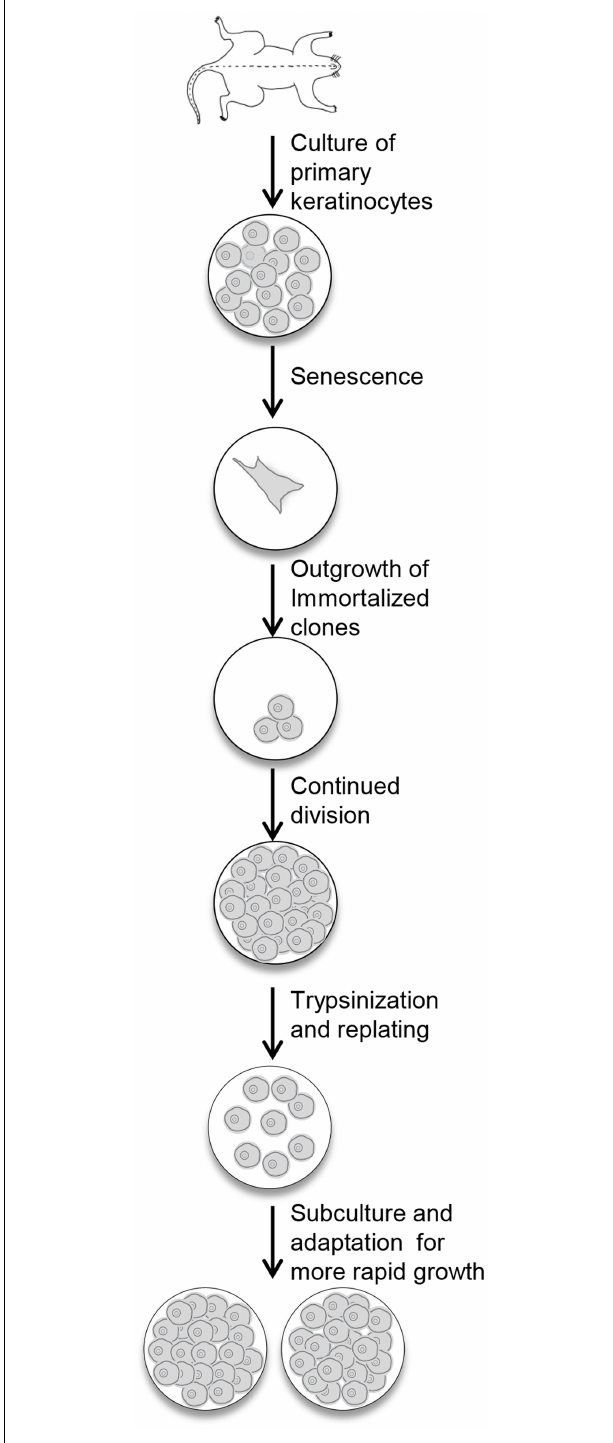
FIGURE 1 | Procedure for the immortalization of mouse keratinocytes . Primary keratinocytes from newborn mouse skin are plated in medium containing KGF. The cells undergo senescence, and the culture dish will look empty. With continued refeeding, the dish will be repopulated with clonal outgrowths. Once these cells reach confluency, they are replated and slowly refilled the dish. With continued subculturing, the cells reach confluency faster, and can be split after trypsinization to expand the culture. Overall survival rate: 48% of wells.